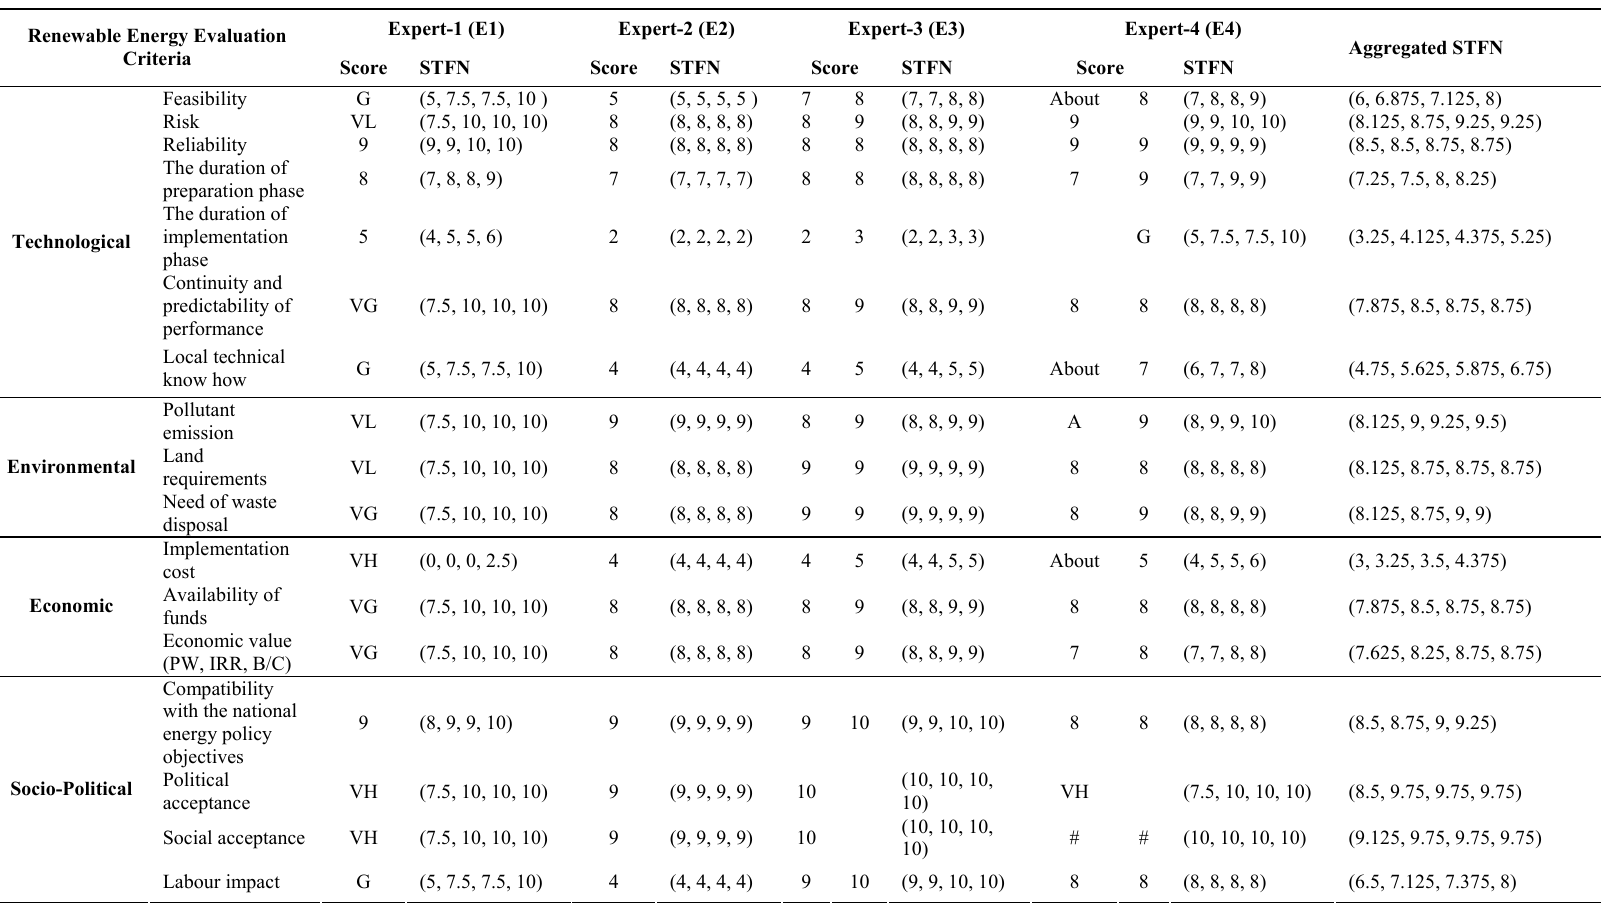
Table 4. Scores and Converted STFN for